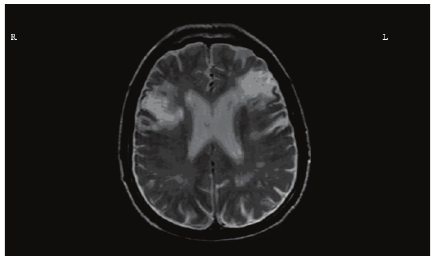
Figure 2: Magnetic resonance imaging sequences demonstrate bilateral inferior frontal gyrus chronic infarct (R: Right, L: